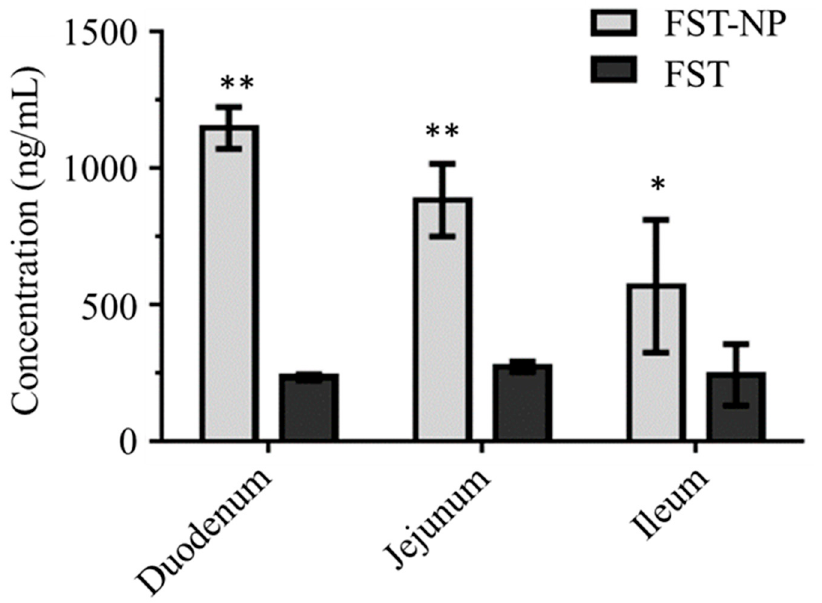
Figure 9. The permeability evaluation of FST and FST–NP. Data are expressed as mean ± standard deviation. ( n = 3); *, ** indicated that FST–NP is significantly different compared with the FST group ( p < 0.05). Table 4. Storage stability test of optimized FST–NP in 5 ± 3 ◦ C and 25 ± 2 ◦